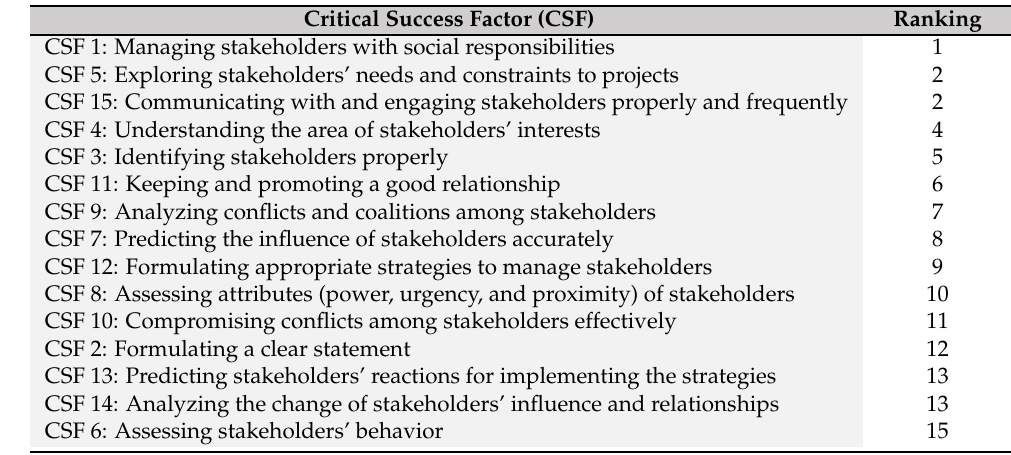
Table 2. Ranking of the CSF adapted from Yang et al. (2010). Critical Success Factor (CSF)